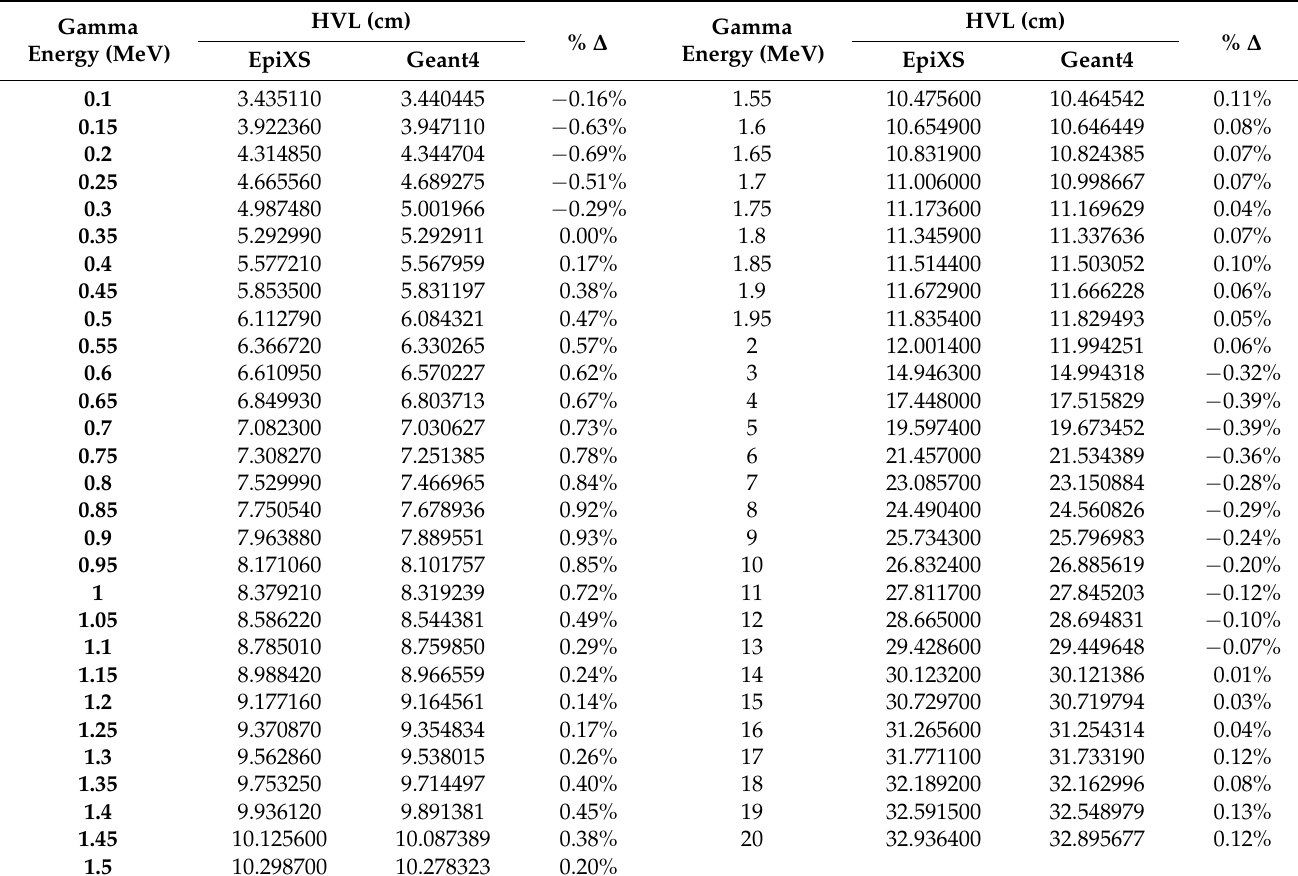
Table 3. The half-value layer of PSU in the investigated energy